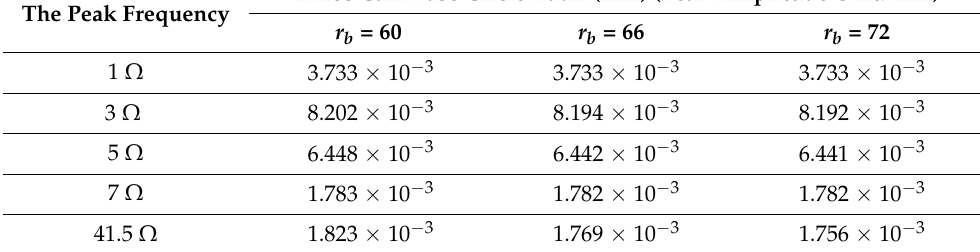
Table 8. The peak amplitude of the lateral vibration spectrum of the follower output node D case where Ω = 320 rad/s and with three cam base circle radii.